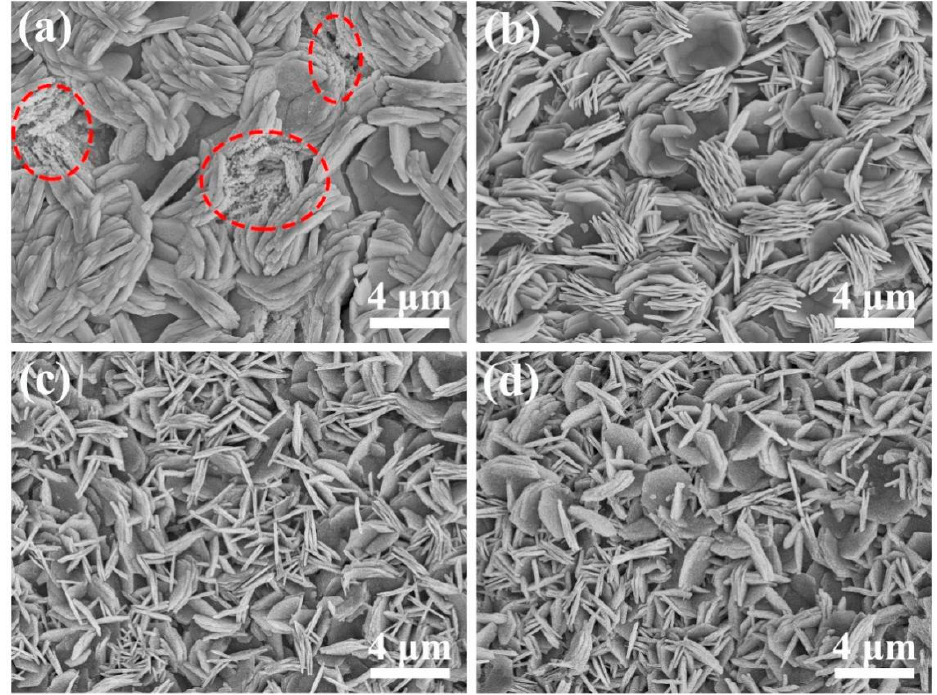
Figure 7. Surface morphology of Sn-0.7Cu- x Ni@C solder after electrochemical corrosion: ( a ) x = 0, ( b ) x = 0.04, ( c ) x = 0.08, ( d ) x = 0.12 wt.%.